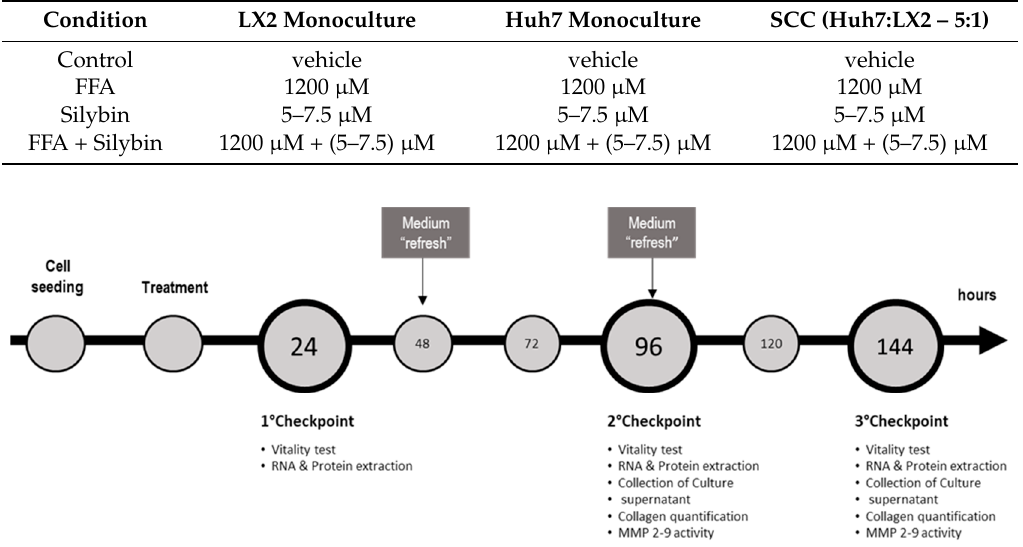
Figure 5. Scheme of the culture proceedings and the experimental checkpoints with the relative determinations.